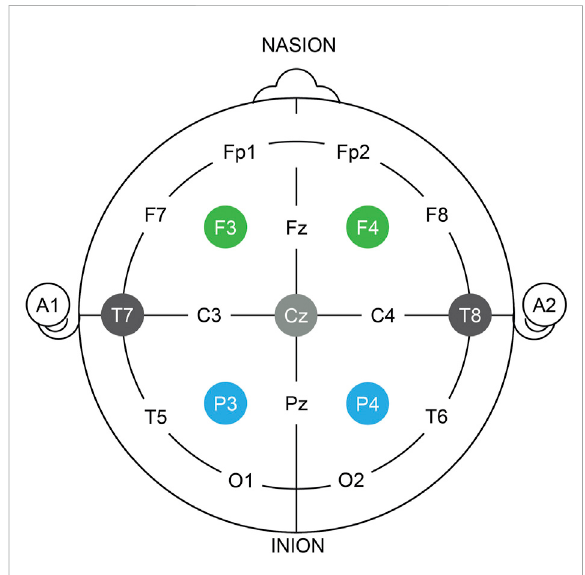
FIGURE 2 Diagram of electrode montage used during the experiment. Seven electrodes were placed, according to the 10 – 20international system.ElectrodesiteswereF3,F4,P3,P4, T7, T8 and Cz, similar to Huster et al. (2009). Reference and ground electrodes were placed in the left and right mastoids,